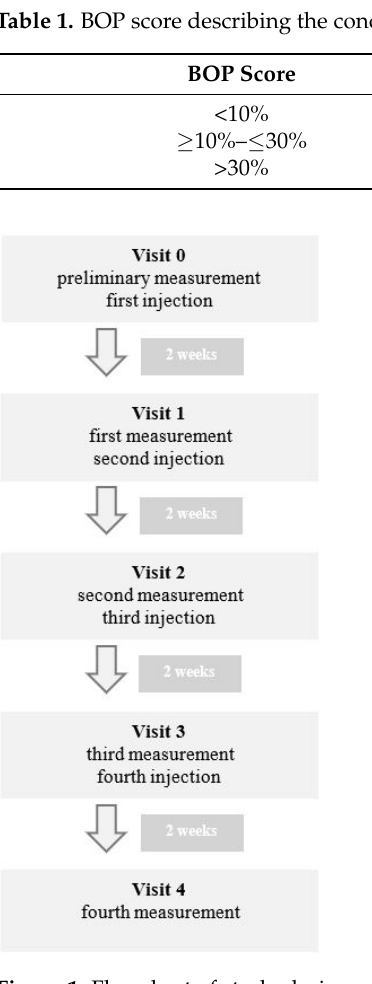
Figure 1. Flowchart of study design. Table 1. BOP score describing the condition of the gingiva.